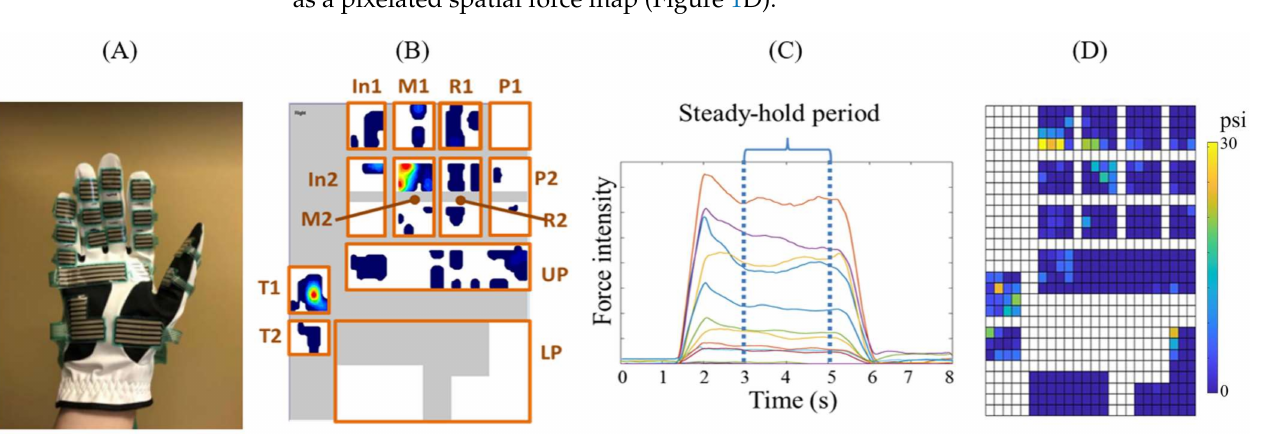
Figure 1. ( A ) GripGlove (Tekscan, Boston, MA, USA) with 12 sensors to capture the contact forces in the 12 hand areas explained as follows. ( B ) 12 areas from where hand forces were recorded, including upper palm (UP), lower palm (LP), distal and proximal phalanx of thumb (T1 and T2), distal phalanges of index, middle, ring and pinky fingers (In1, M1, R1, P1) and middle-proximal phalanges of four fingers (In2, M2, R2, P2). ( C ) Recorded average forces during the steady-hold period. Colors indicate the 12 areas. ( D ) Recorded spatial force maps pixelated corresponding to the 12 hand